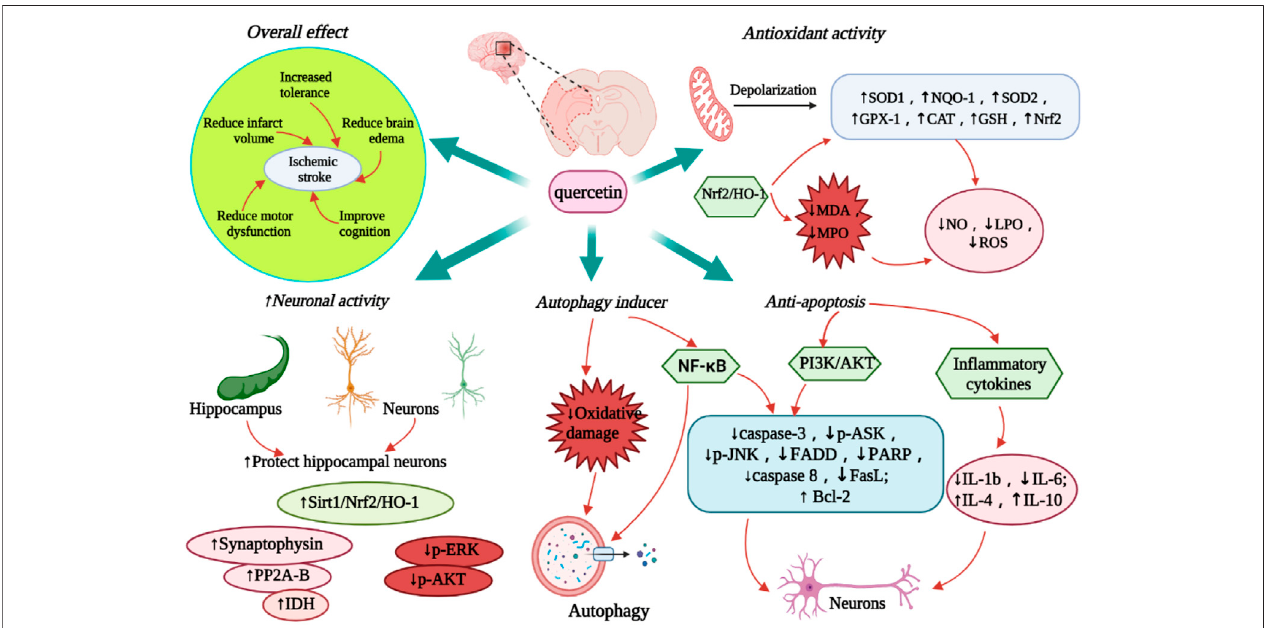
FIGURE 3 | Diagram of the neuroprotective effect of quercetin on IS. The fi gure highlights the overall therapeutic effect of quercetin, anti-oxidative stress, anti- apoptosis, promoting autophagy and neuroprotective activity. Abbreviations: ↑ , increase; ↓ , decrease; SOD, Superoxide dismutase; NQO-1, NAD(P)H dehydrogenase quinone-1; GPX-1, glutathione peroxidase-1; CAT, catalase; NOS1, nitric oxide synthase 1; GSH, glutathione; Nrf2, nuclear factor 2-related factor 2; HO-1, Heme oxygenase-1; NO, nitric oxide; LPO, lipid peroxidation; ROS, reactive oxygen species; IL, interleukin; Sirt1, sirtuin 1; NF-kB, nuclear factor kappa B; IDH, isocitrate dehydrogenase; PP2A, Protein phosphatase 2A; FADD, Fas-associated death domain; PARP, poly (ADP-ribose) polymerase; PI3K, phosphoinositide 3-kinase; AKT, protein kinase B; ASK, apoptosis signal-regulating kinase; JNK, c-Jun N-terminal protein kinases; ERK, extracellular-signal-regulated kinase; FasL, factor associated suicide